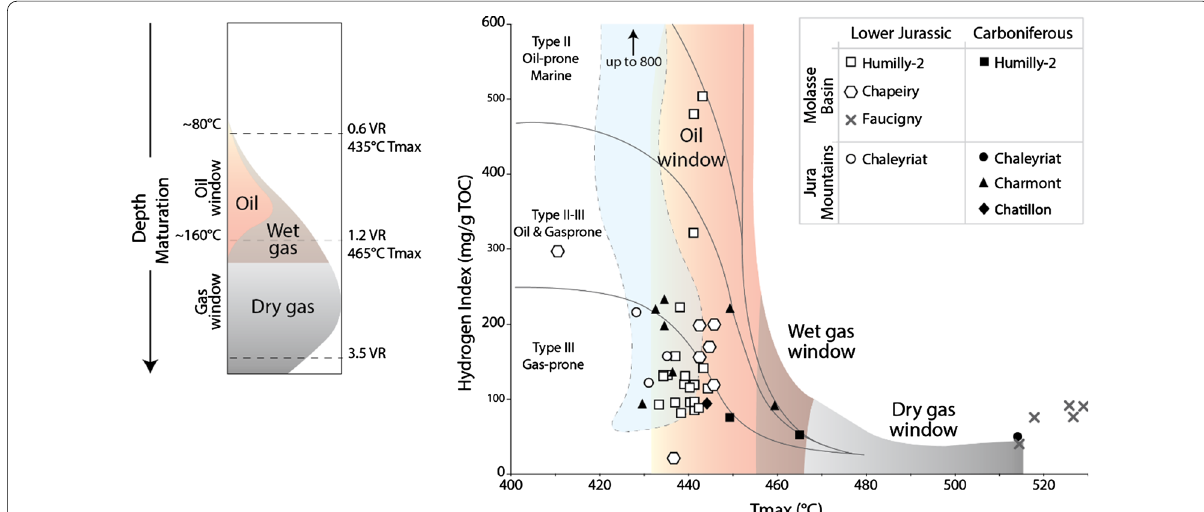
Fig. 5 Hydrogen Index (HI) vs. Tmax crossplot outlining the kerogen types and source-rock maturity of the Lower Jurassic and Carboniferous units. Only samples with TOC > 0.5% are plotted in this graph. The blue shaded area encompasses available data for the Lower Jurassic Posidonia shales in the northwestern Swiss Molasse Basin (Todorov et al. 1993; Fantasia et al.